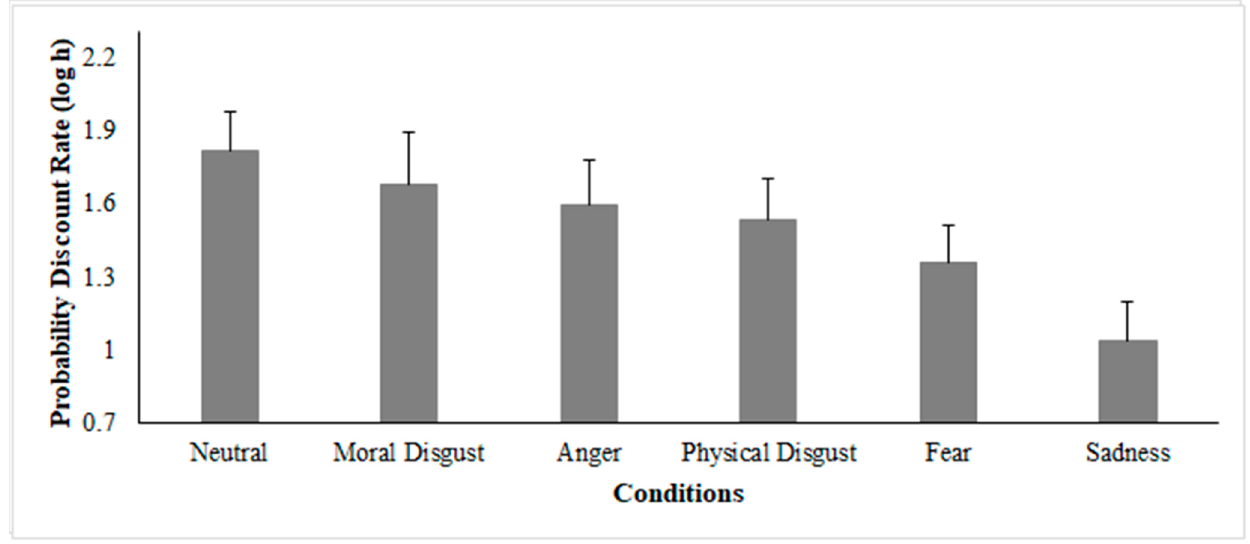
Figure 5. Results of the LMM (Experiment 2). Analyses conducted on the individual probability discount rates (log h) using the fixed effect of the condition (Anger, Sadness, Fear, Moral Disgust, Physical Disgust, Neutral). Table 8. Results of the LMM, conducted in Experiment 2. Analyses conducted on the individual probability discount rates (log h) using the fixed effects of the condition (Ager, Moral disgust, Physical Disgust, Neutral).